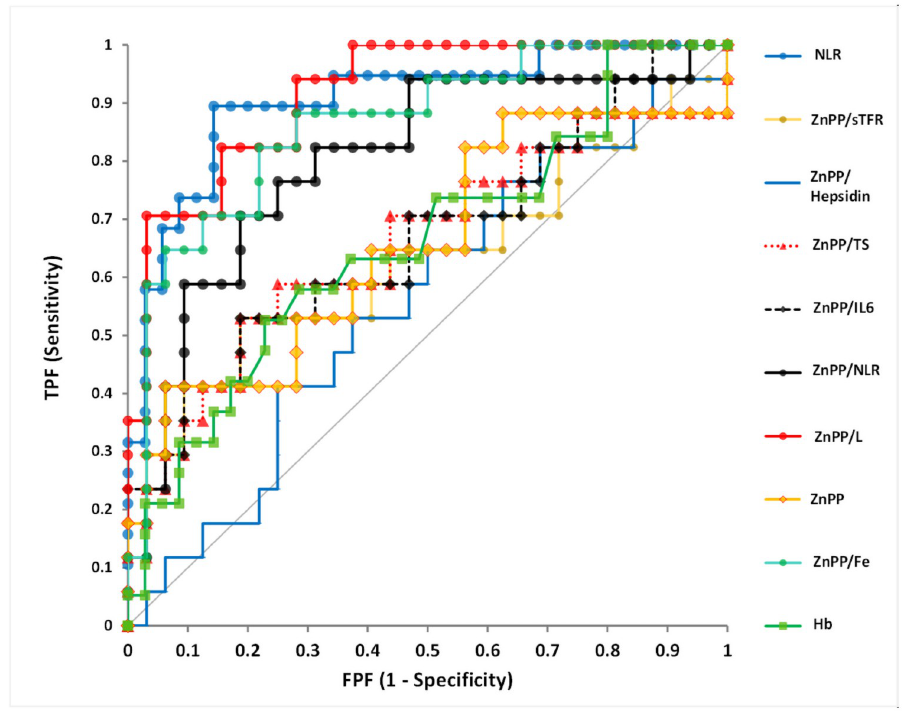
Fig 2. Receiver operating characteristic (ROC) curves displaying the sensitivity and specificity of NLR, ZnPP/ sTFR, ZnPP/Hepcidin, ZnPP/TS, ZnPP/IL-6, ZnPP/NLR, ZnPP/L, ZnPP, ZnPP/Fe, Hb on distinguishing COVID-19 severity. NLR: N/L Ratio, ZnPP: Zinc Protoporphyrin, sTFR: soluble Transferrin receptor, TS: Transferrin Saturation; L: Lymphocyte, Hb: hemoglobin.